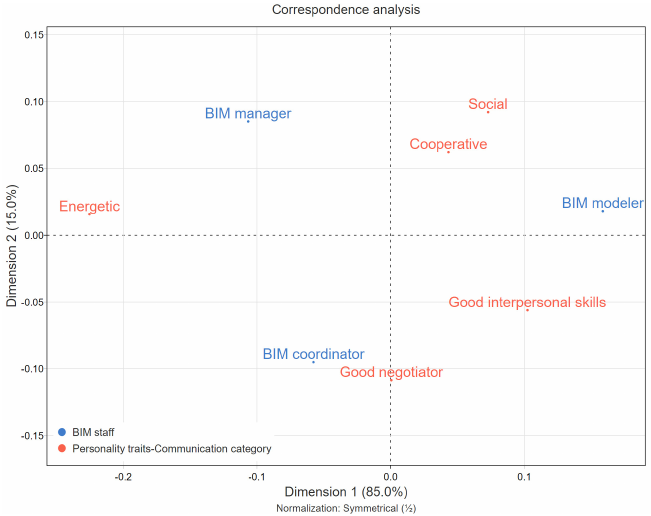
Figure 6. Comparison of the required degree of personality traits (communication category) between BIM staff roles—Correspondence analysis.